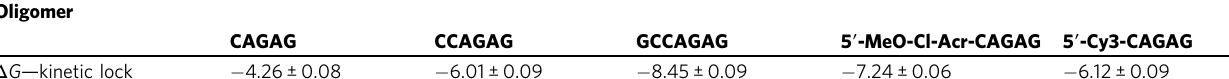
Fig. 2 Measurement of the hybridization energy of short oligonucleotides with kinetic locking. a Description of the assay. When an oligonucleotide binds to the probe, it blocks it transiently in the open state. b Larger time view of the measured extension of the hairpin in the absence of oligonucleotide in solution (top) and in the presence of the complementary 7-mer (bottom). c Distribution of the times spent by the DNA probe in its open state as a function of the concentration of 7-mer. The clear double-exponential distribution allows us to deduce the binding rates k on and k off . d Relative evolution of the mean time spent by the DNA probe in the open state T open as a function of the concentration of 7-mer. The slope allows us to compute the energy of binding. Y errors are computed through bootstrap resampling. X errors are based on a putative error of 5% on the concentration. Each data point consists of the averaging of at least 7000 events. e Free energies of binding of fi ve different oligonucleotides measured with kinetic locking. The sequence of the probe is shown in green and the sequences of the oligonucleotides are in blue. Cy3 and acridine modi fi cations increase substantially the binding energy. Errors are based on the covariance of the parameters inferred from the linear fi ts like the one shown in ( d ).